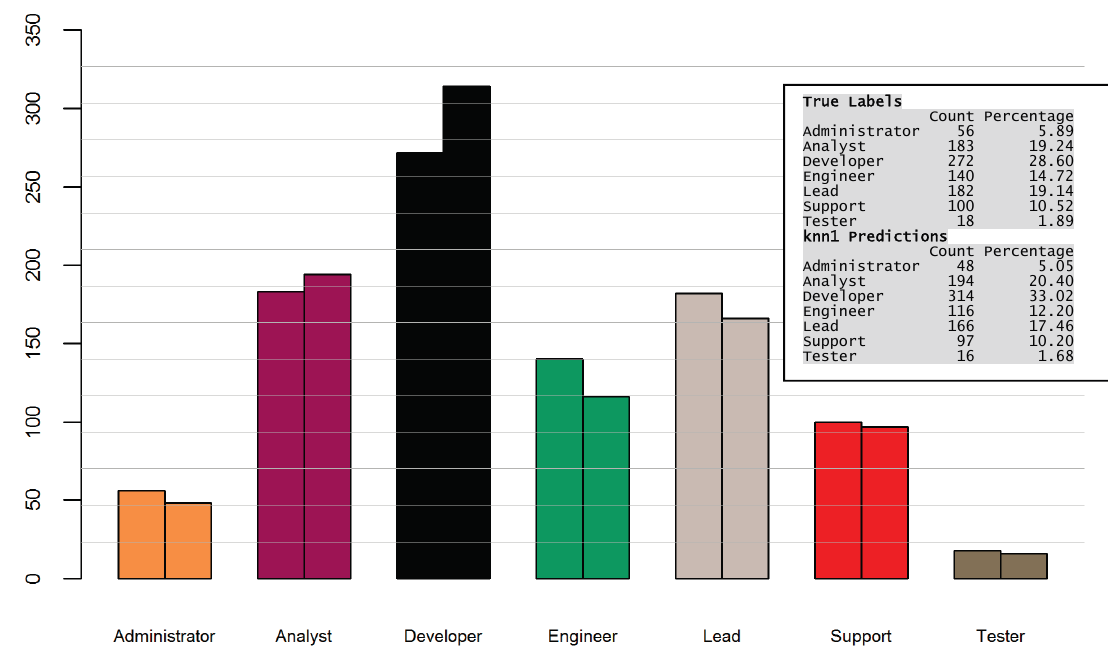
Figure 9. Distribution of true labels (left bar) and classification predictions (right bar).